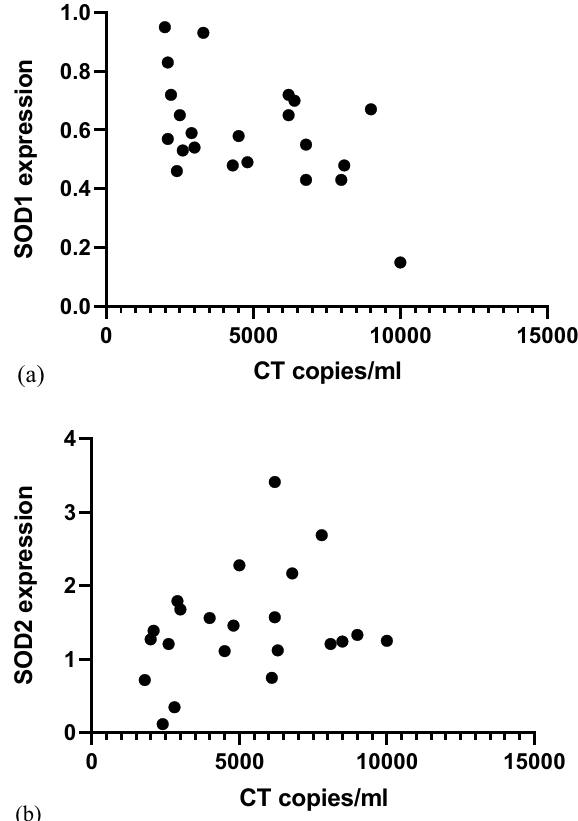
Figure 5. Determination of correlation between Chlamydia trachomatis copy load ( a ) SOD1 ( b ) SOD2 gene expression in C. trachomatis -positive recurrent spontaneous aborters (Spearman rank correlation test). CT Chlamydia trachomatis.